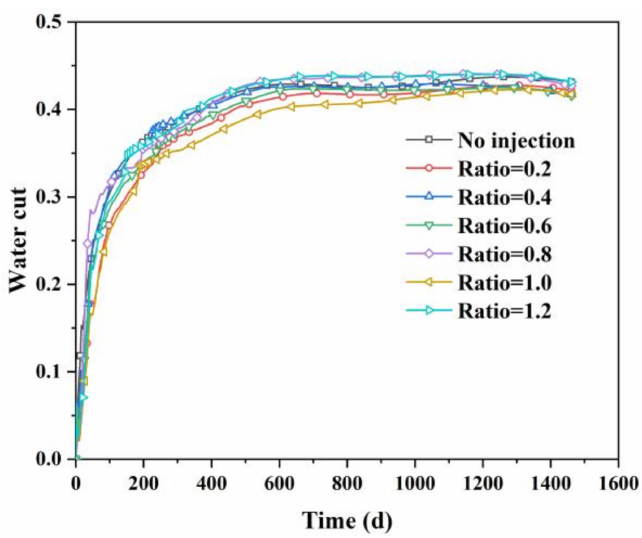
Figure 10. Water cut of infill